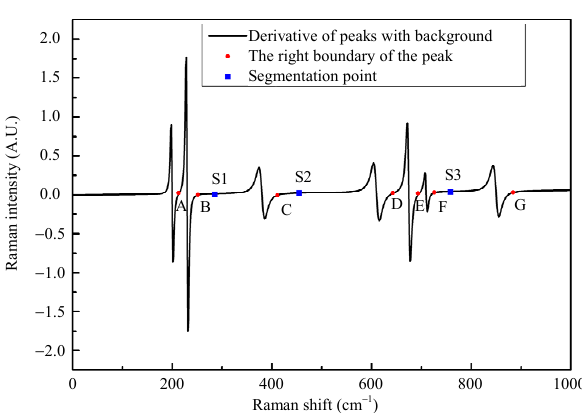
Fig. 4 Derivative of the synthetic Raman